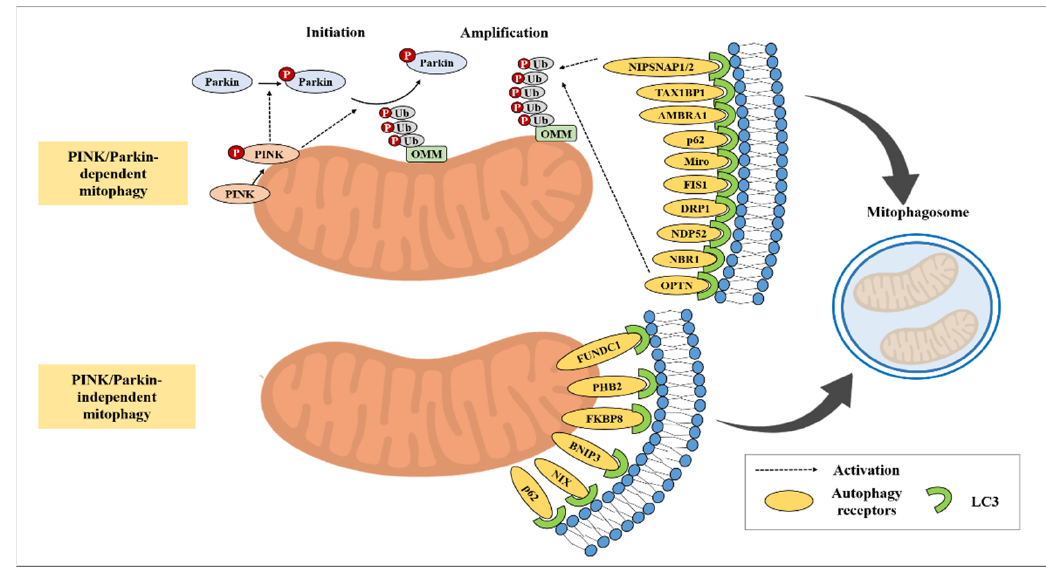
Figure 2. Pink1/Parkin-dependent and -independent mitophagy pathway. Table 3. Role of representing proteins on mitophagy process.